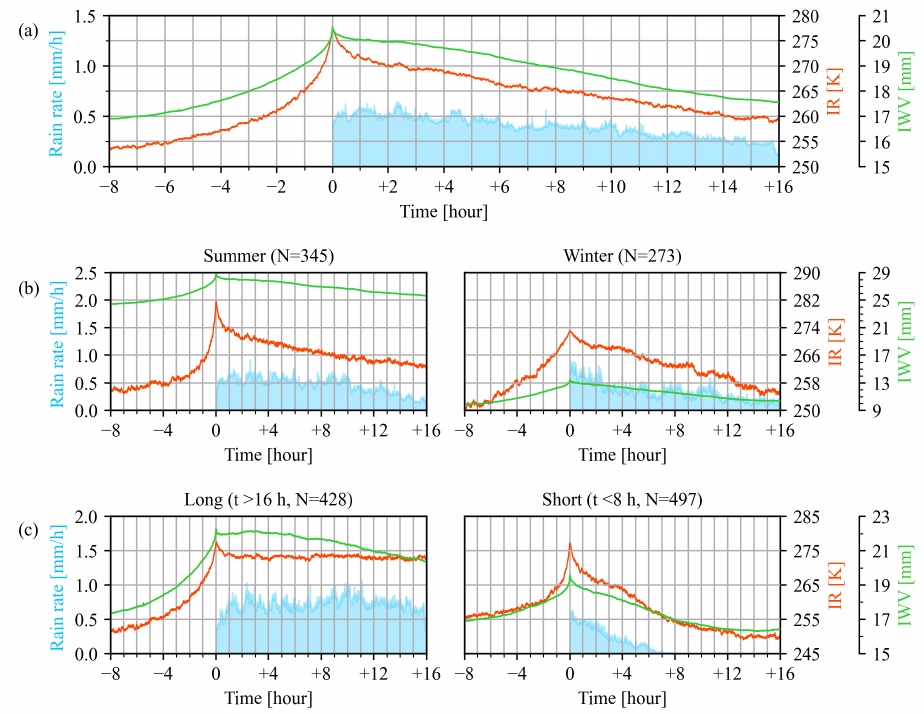
Figure 2. Composites of ( a ) IWV (green solid line), T IR (red solid line), rain rate (blue area) 8 h before and 16 h during rain, considering the rain events ( b ) in summer and winter, as well as ( c ) with long and short